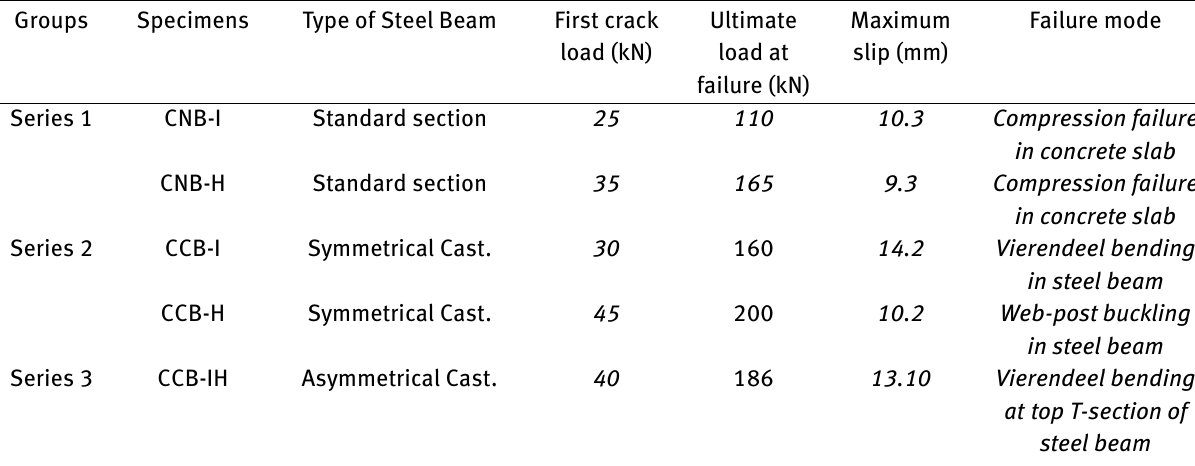
Table 3: Experimental results of composite specimens Groups